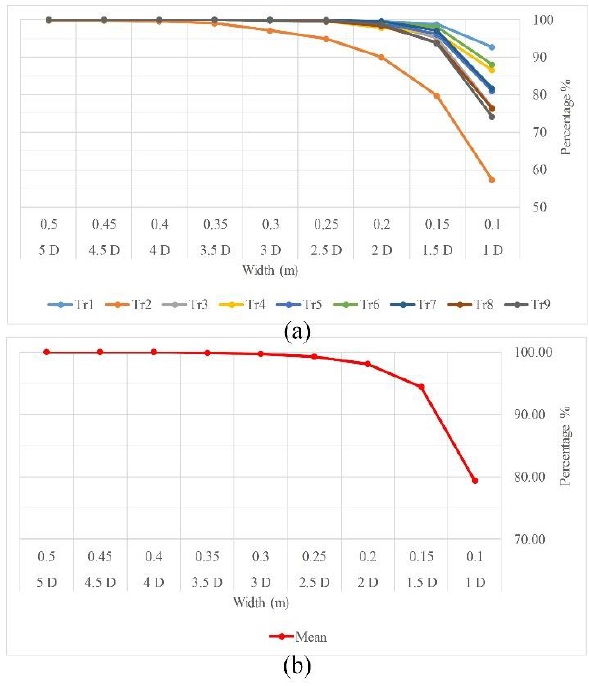
Figure 6 . The relationship between the cube width and the removal percentage. a) Results of nine tree sets, b) Average results.